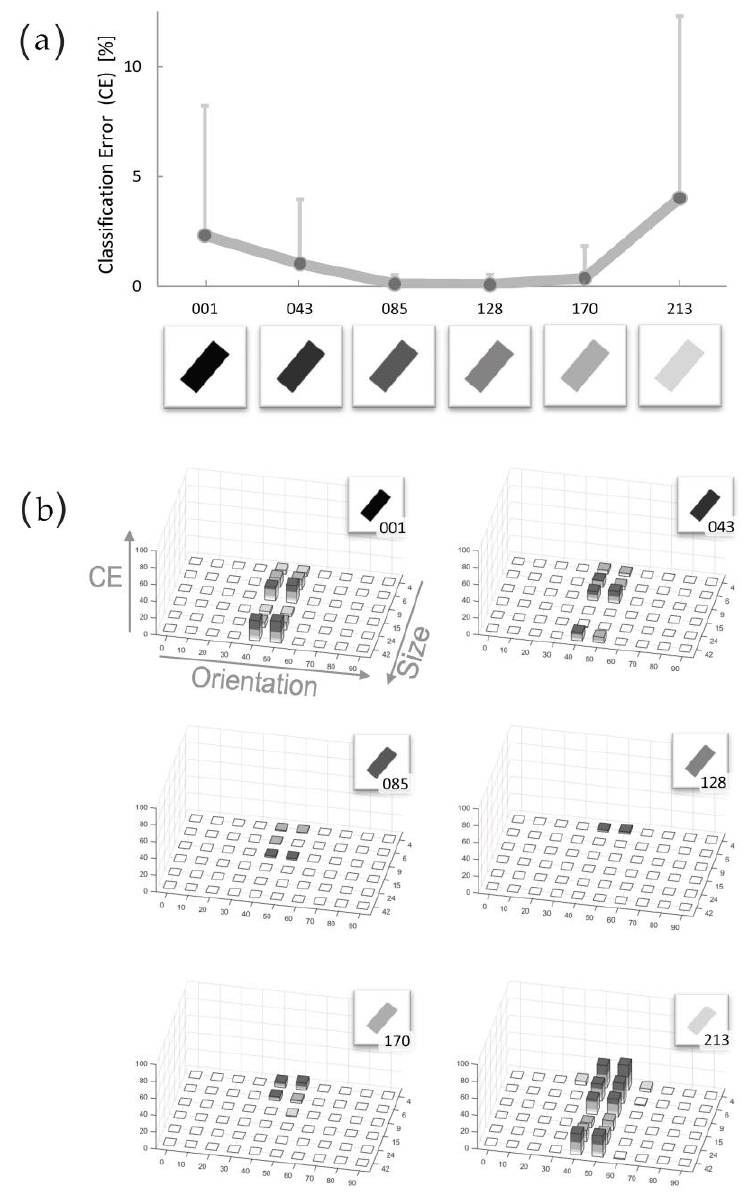
Figure 4. Uniform Bars on uniform Background: manipulation of Bar Luminance. To measure the HMAX performances we define the Classification Error (CE), which is the sum of classification errors, which has occurred over 100 trials, for each individual item. Consequently, CE is a measure of the loss-of-effectiveness in classification, expressed in terms of percentage: the larger is the CE, and the poorer and unreliable are the performances. ( a ) Results of tests on uniformly filled Bars on a white background; the graph presents the mean values and standard deviations of CE for the six experimental conditions, corresponding to six Luminance values reported in the X-axis. The graph reveals that HMAX provides the best results with mid-range Luminance Bars. ( b ) Detailed results for each Luminance condition (luminance value is specified under the Bar icon). In each histogram, X and Y axes report, respectively, the ten orientations and the six sizes characterizing each item, as previously presented in Figure 3.